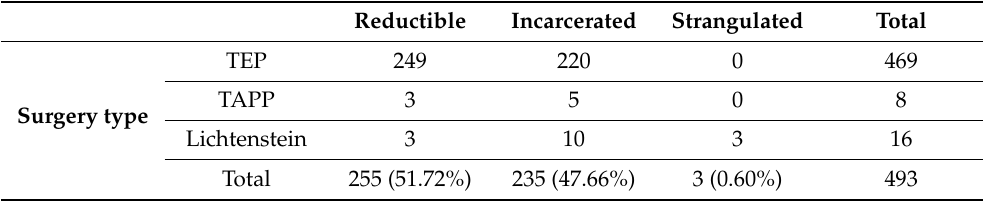
Table 6. The type of hernia and laparoscopy used as a surgical solution (2).